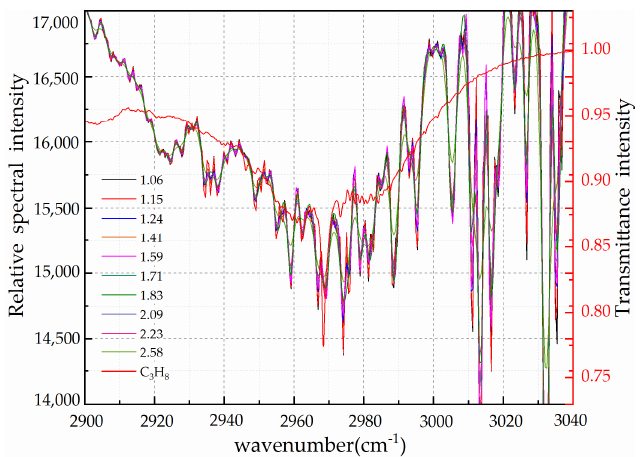
Figure 6. The C 3 H 8 spectrum with different apodization degrees and the C 3 H 8 standard transmis- sivity spectrum.